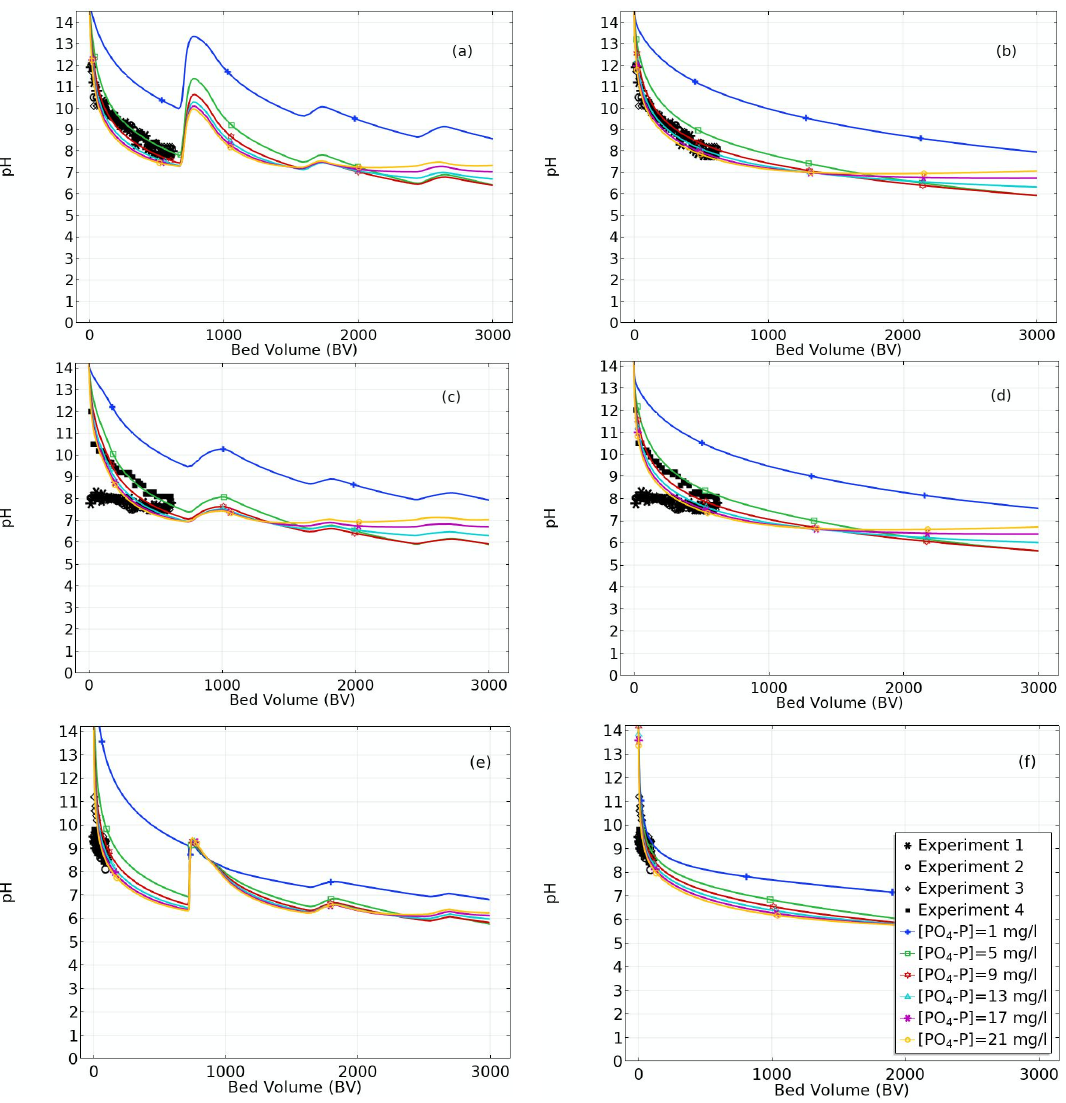
Figure 3. Change in pH as a function of number of wastewater BV treated by the different RFM types. Data from column experiments 1–4 [17] as black points and simulated data for a range of P concentrations shown as coloured lines. (Legend in diagram (f)) Intermittent flow through ( a ) Polonite, ( c ) Top16, ( e ) Filtralite P. Continuous flow through (right-hand diagrams) ( b ) Polonite, ( d ) Top16, ( f ) Filtralite P.